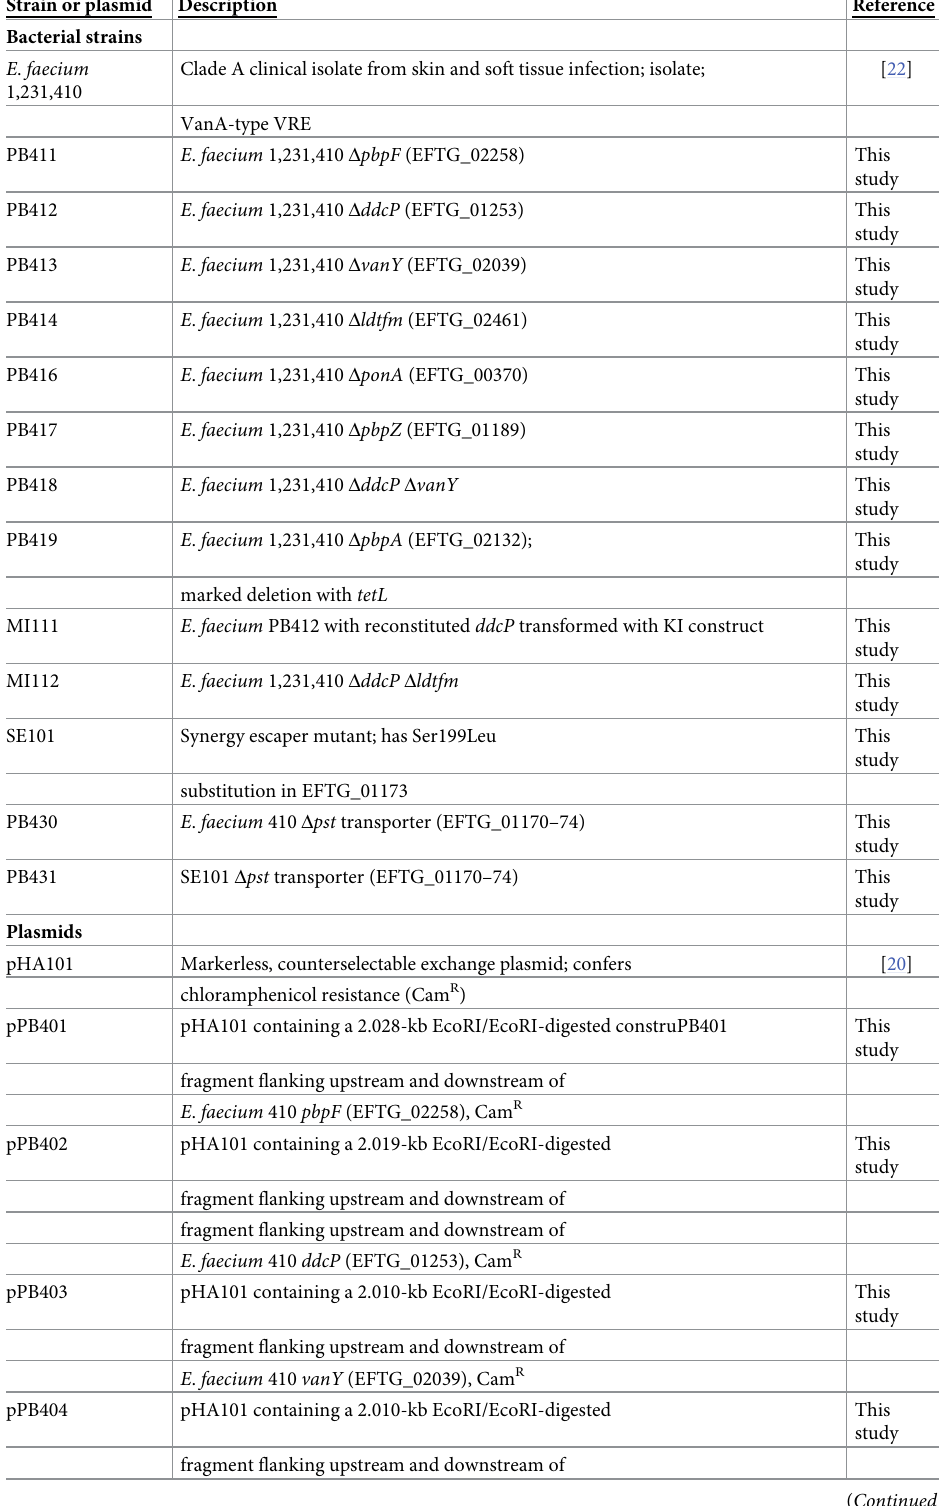
Table 1. Bacterial strains and plasmids used in the